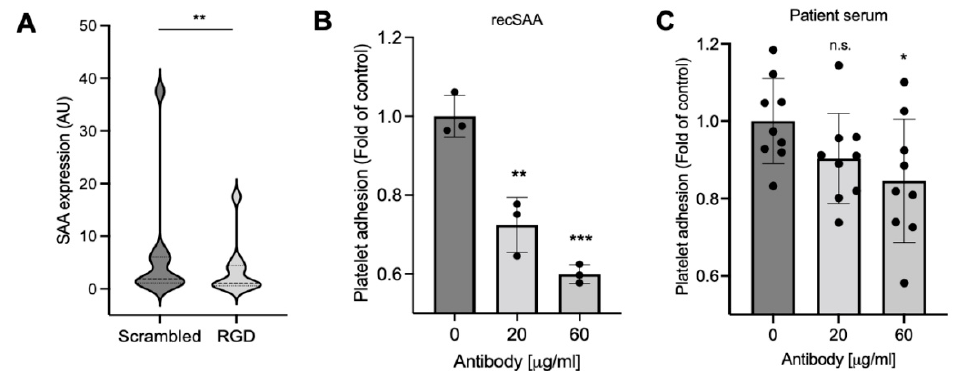
Figure 5. SAA increases platelet adhesion through the integrin receptor. ( A ) Platelets from a healthy donor were incubated at 37 °C for 1 h with COVID-19 serum with an RGD or a scrambled (Scr) peptide. The platelet protein lysates were separated using SDS-PAGE. SAA was detected using a specific anti- body. Tubulin was used as a loading control. Densitometric results are shown using the serum from 10 patients. Wilcoxon test, ** p = 0.004. ( B ) Recombinant SAA was used to coat the wells of a microtiter plate. Healthy platelets were incubated with or without a specific anti-integrin α II β 3 receptor antibody. The treated platelets were washed and added to the SAA-coated wells. Adhesion was determined using the acid phosphatase assay. ( C ) Healthy platelets were incubated with or without anti-integrin α II β 3 recep- tor-specific antibodies. The treated platelets were washed and added to wells coated with COVID-19 patient serum. Adhesion was determined using the acid phosphatase assay. Values are the mean ± standard deviation from three independent experiments. Ordinary one-way ANOVA, Dunnett’s multiple comparisons test, ns = non-significant, * p < 0.05, ** p < 0.01, *** p < 0.001.